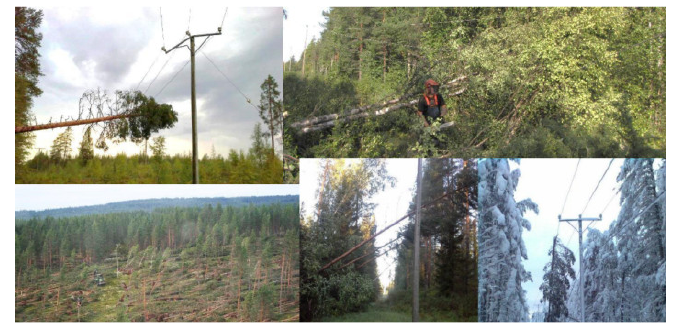
Figure 25. Post-storm infrastructure monitoring.